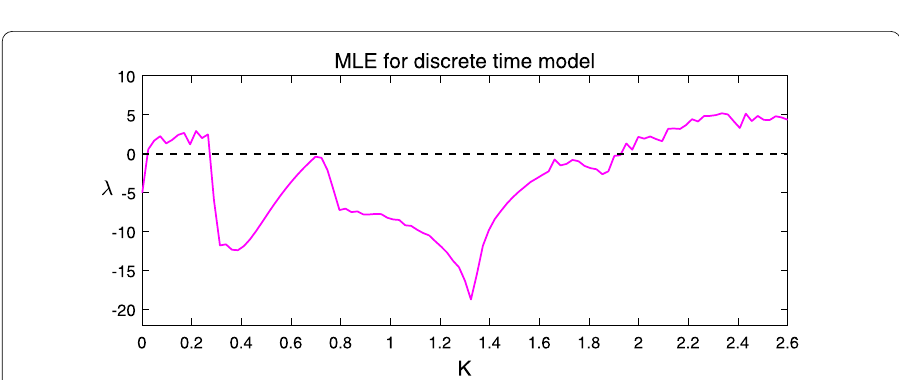
Figure 5 Spectrum of the maximum Lyapunov exponent (MLE) versus K for the discrete-time model. The parameters are defined in Table 1 except that b = 2.9 and K varying from 0 to